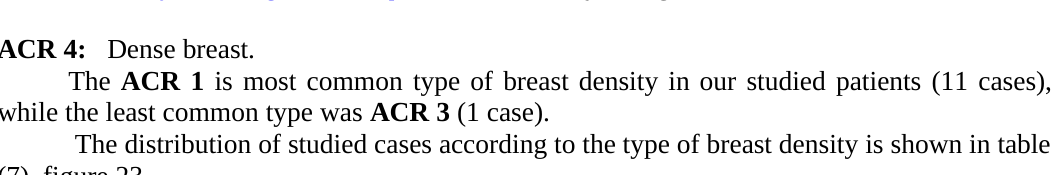
Table (7): Distribution of studied cases according to ACR (n = 20)